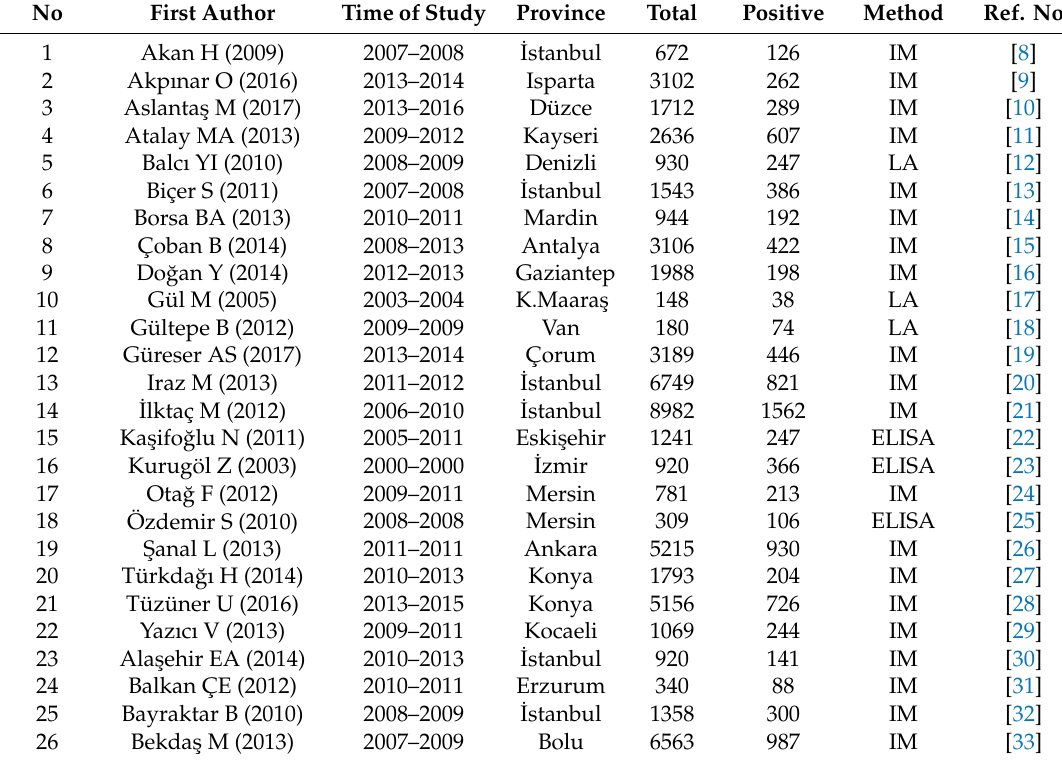
Figure 1. Flowchart of selection of utilized studies in meta-analysis. Table 1. Characteristics of studies included in meta-analysis.